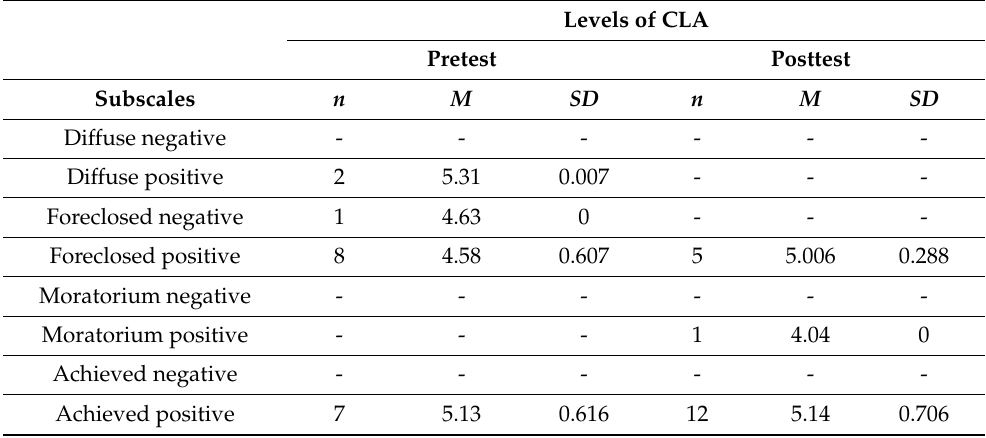
Table 7. Means and Standard Deviations of levels of CLA by Ethnic Identity Scale (EIS) Type ( N = 18).